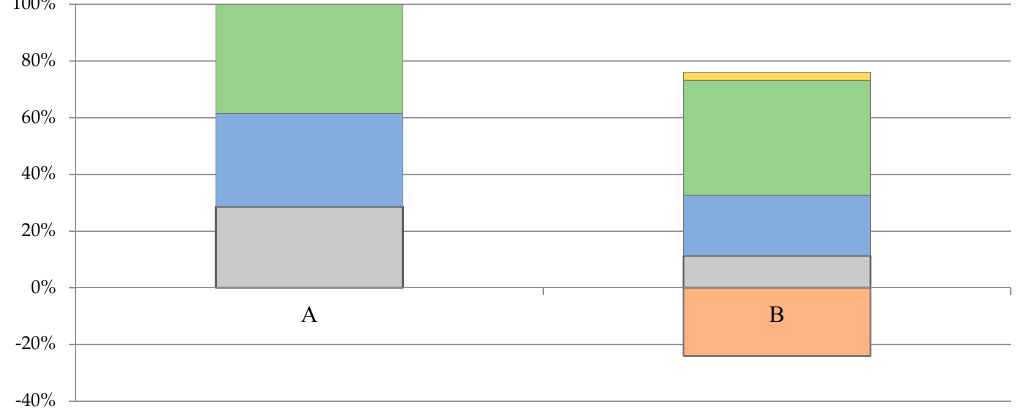
Figure 4. Structure of operating costs in the analysed agricultural biogas plants.